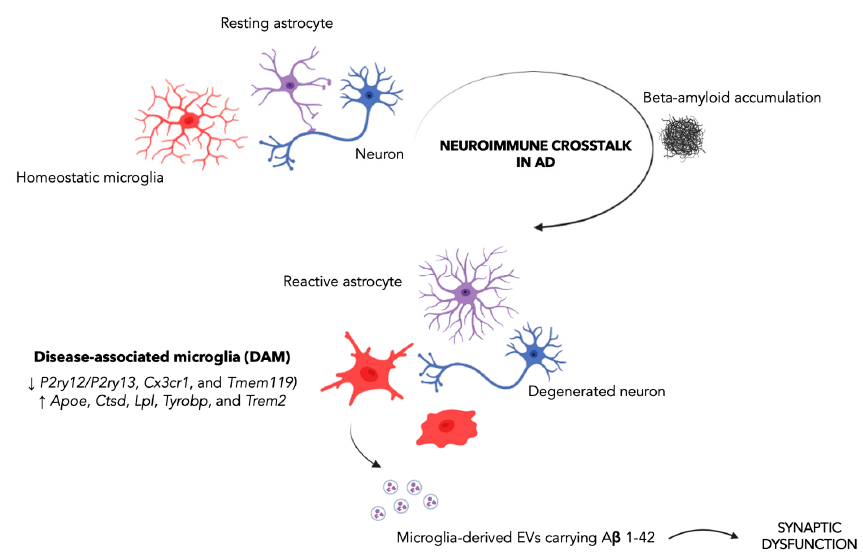
Figure 1. The disease-associated microglia as a driver of synaptic dysfunction in Alzheimer’s disease. The neuroimmune crosstalk between astrocytes, microglia, and neurons plays a crucial role in AD. In particular, it has been proposed that, in the early stage of the disease, microglia exert a neuroprotective effect by phagocytosing A β . Instead, in late-stage AD, chronic stimulation of microglia promotes microglia transition from a homeostatic to an increasingly pro ‐ inflammatory state, with a negative impact on synaptic function. Specifically, large EVs (ectosomes) containing A β 1–42 have been reported to impair synaptic plasticity, thereby contributing to initial synaptic dysfunction. The Figure was created with BioRender.com.